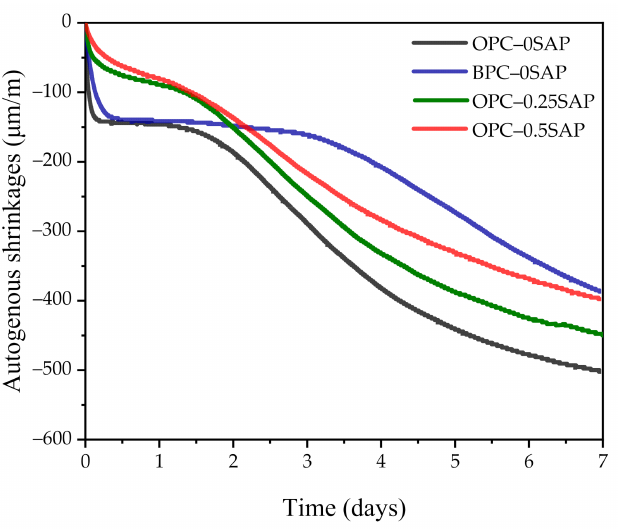
Figure 5. Autogenous shrinkage (AS) of sustainable ultra-high-performance paste (SUHPP) hydrated for 7